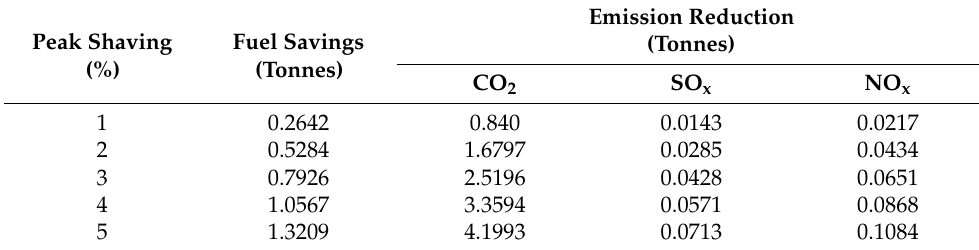
Table 12. Reductions from peak shaving for Route